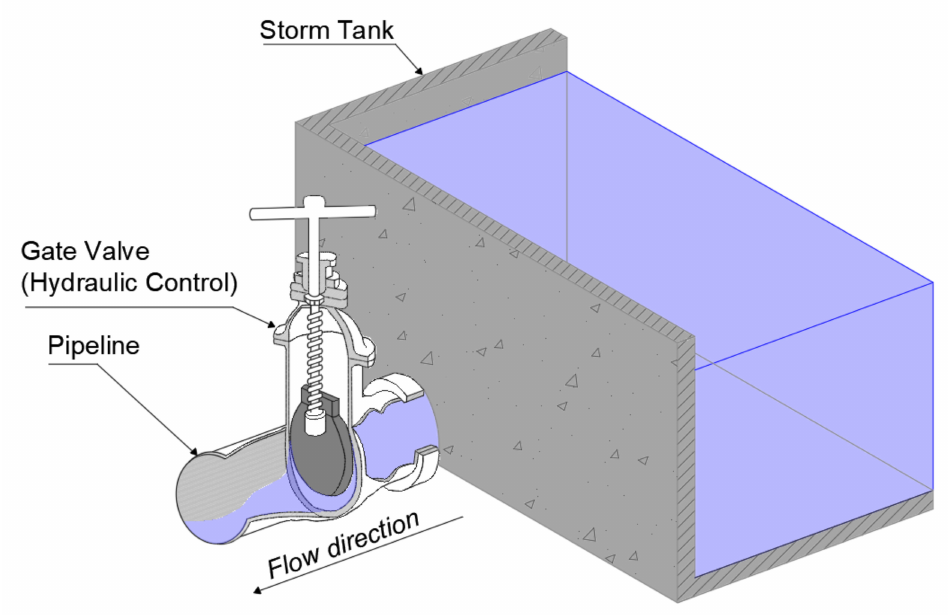
Figure 1. Gate valve installed as a hydraulic